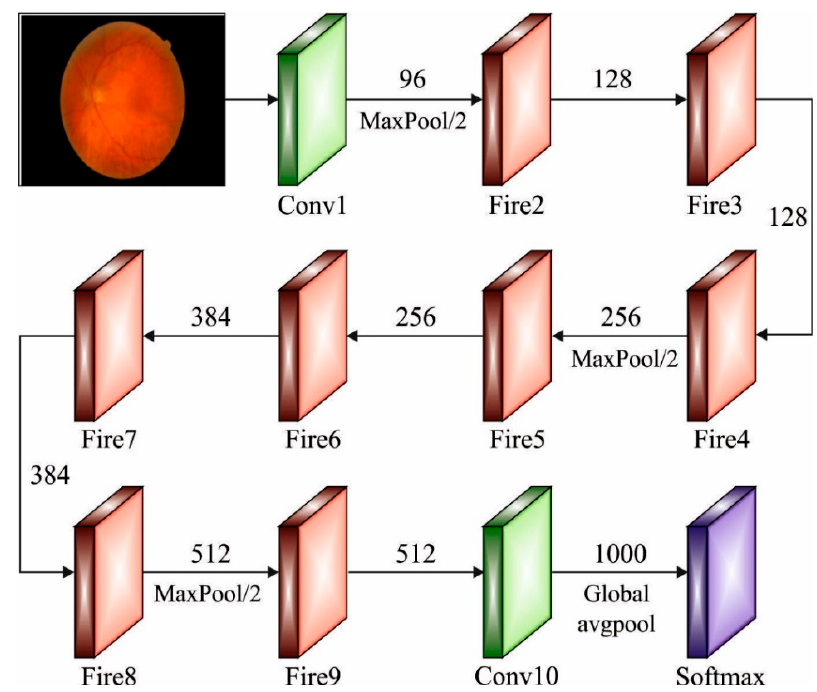
Figure 2. Structure of SqueezeNet.